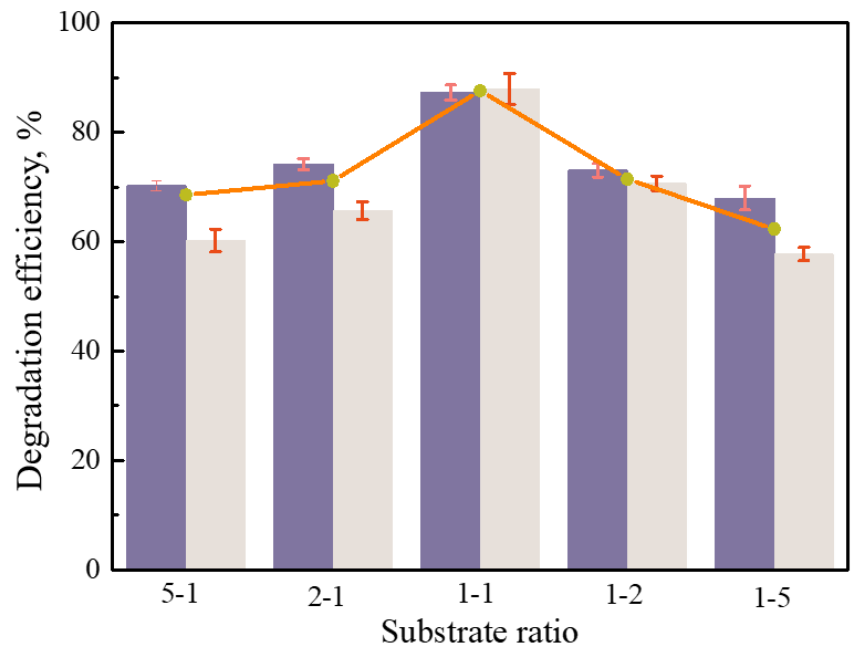
Figure 6. The degradation efficiency of chlorobenzene with different mixed waste gas concentrations. Inlet concentration of mixed waste gas = 800 mg · m − 3 , liquid rate = 5.17 m 3 · m − 2 · h − 1 , pH = 6.5–7.0, oxygen concentration = 10%. ■ Xylene degradation efficiency ■ Chlorobenzene degradation efficiency.